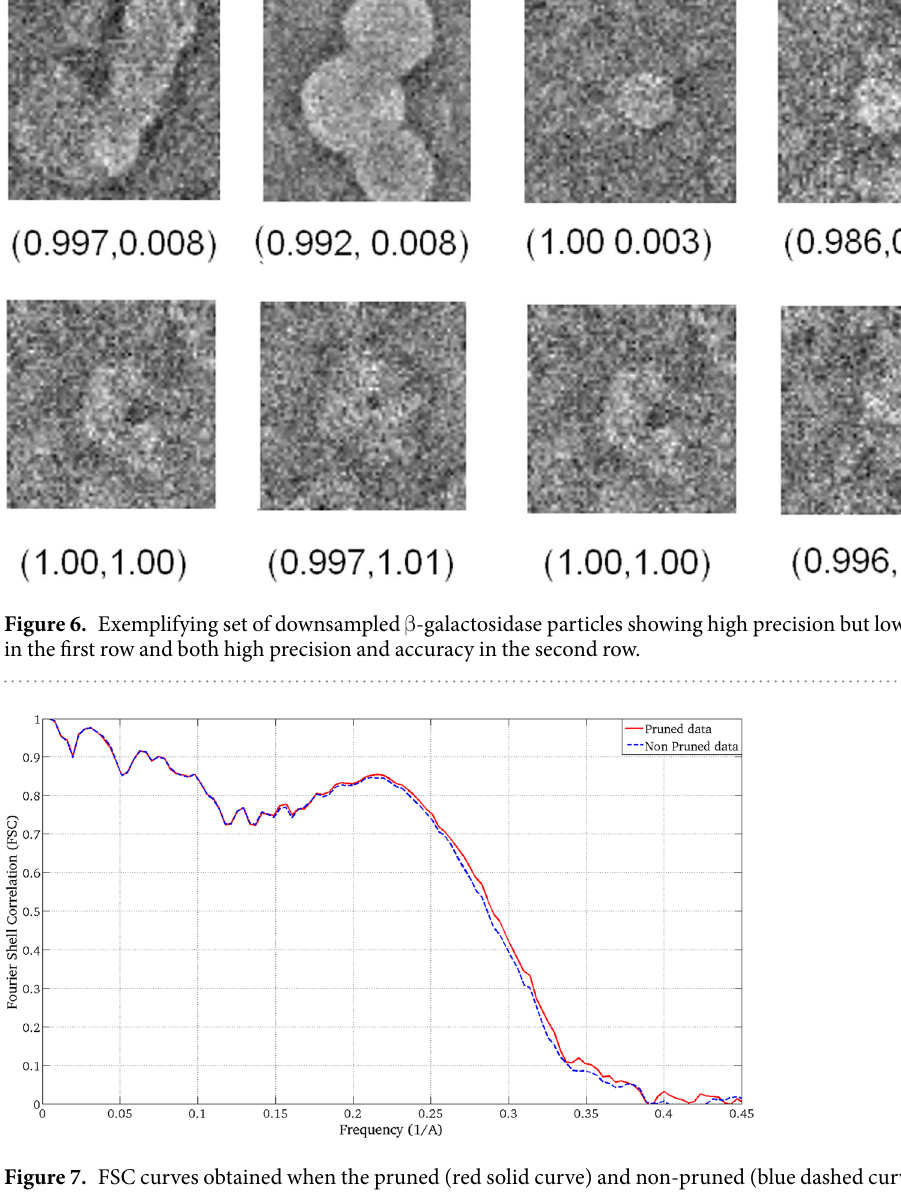
Figure 7. FSC curves obtained when the pruned (red solid curve) and non-pruned (blue dashed curve) 3DEM maps obtained for the β -galactosidase complex are confronted with the PDB